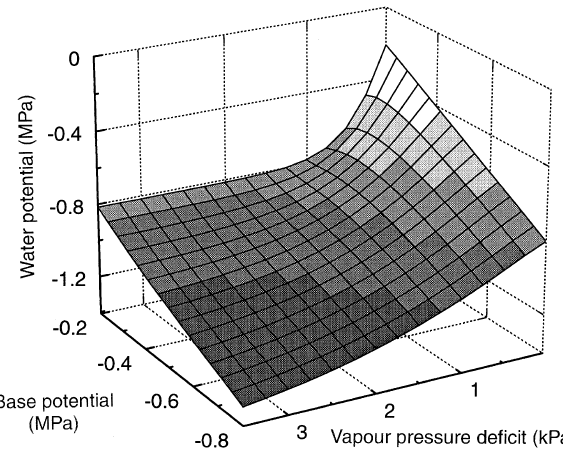
Fig. 4. The shoot water potential (cid:133) (cid:87) x (cid:134) as a function of the base water potential (cid:133) (cid:87) b (cid:134) and vapour pressure deficit (VPD). The means for the intervals of (cid:87) x indicated with the consecutive tones from white to dark grey : (cid:255) 0 : 40 ; (cid:255) 0 : 58 ; (cid:255) 0 : 76 ; (cid:255) 0 : 94, and (cid:255) 1 : 12